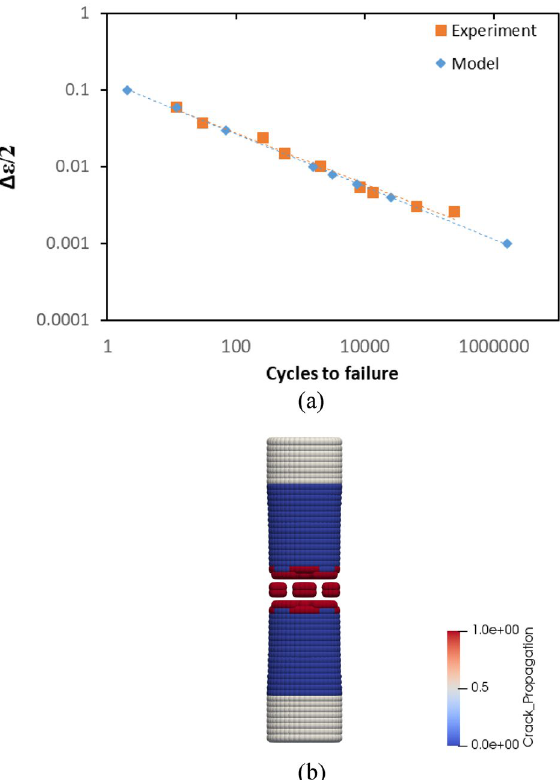
Figure 9. Rail steel. ( a ) A comparison between the experiment and PD simulation in the case of crack initiation. ( b ) A picture of failure mode for crack initiation from PD